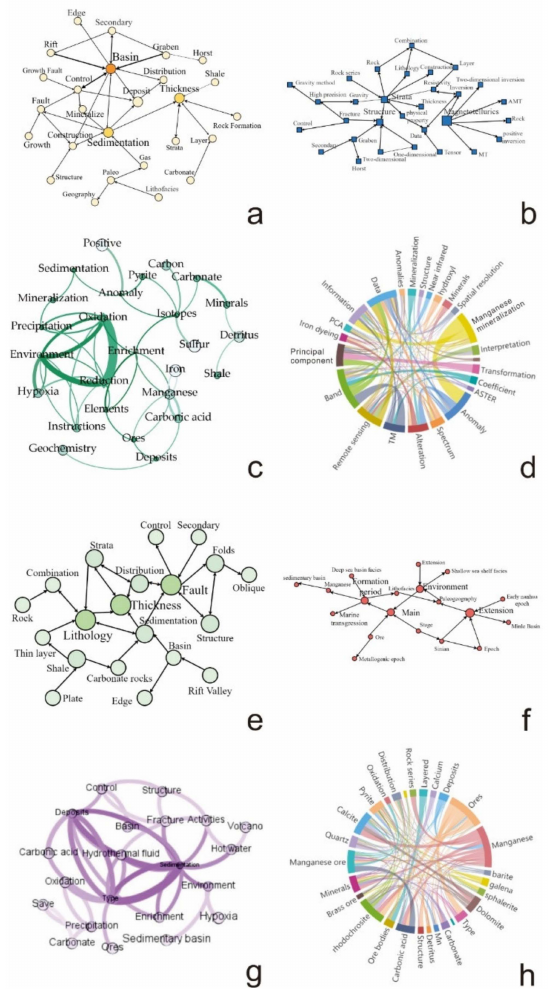
Figure 9. Visualization of semantic relationships extracted: ( a ) ternary diagram of geological prospect- ing, ( b ) ternary diagram of geophysical prospecting, ( c ) ternary diagram of geochemical prospecting, ( d ) chord diagram of remote sensing, ( e ) ternary diagram of metallogenic background, ( f ) ternary diagram of metallogenic period, ( g ) ternary diagram of genetic type, and ( h ) chord diagram of mineralization